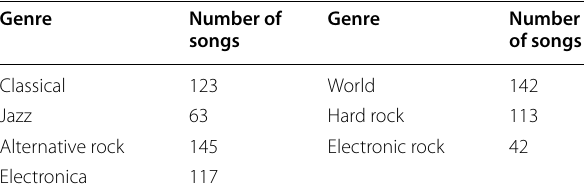
Table 1 The number of songs per genre used for the experiment